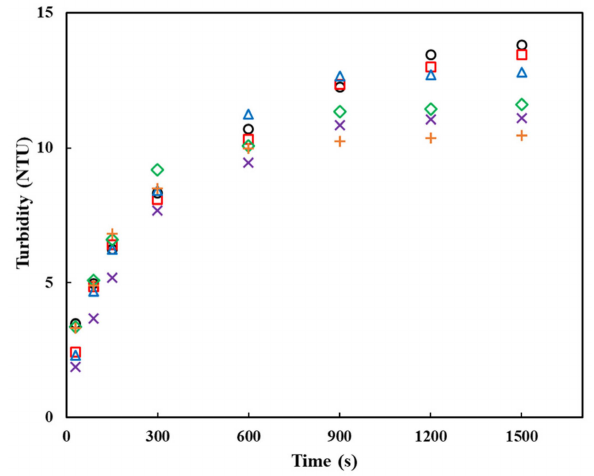
Figure 4. Plots of turbidity versus dissolution time of raw and agglomerated PPSPs with different concentrations of MD binder: ( (cid:35) PPSP—30%, and (+) PPSP—40%.